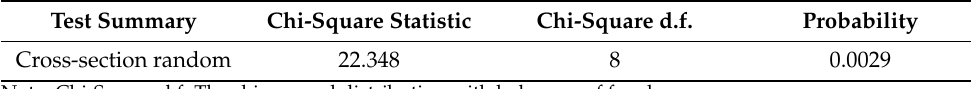
Table 7. Correlated random effects-Hausman